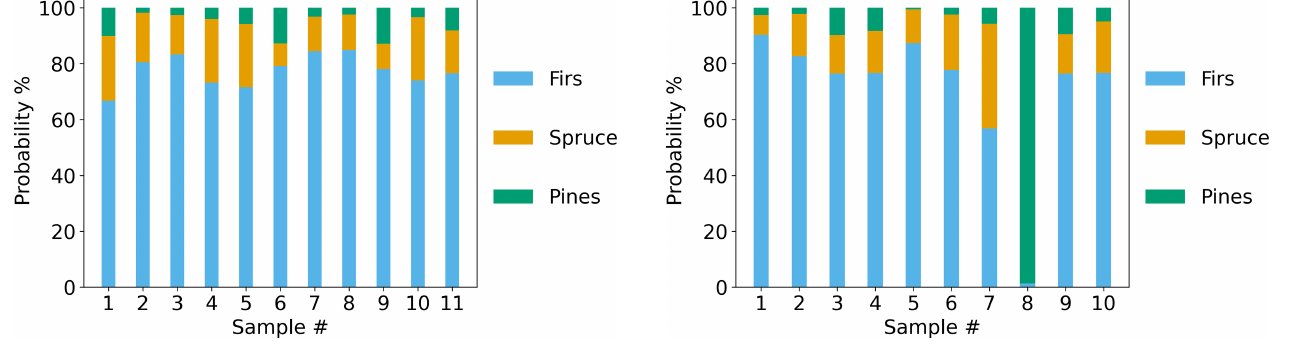
Figure 14. Classification probability by fuel class for plot 60.